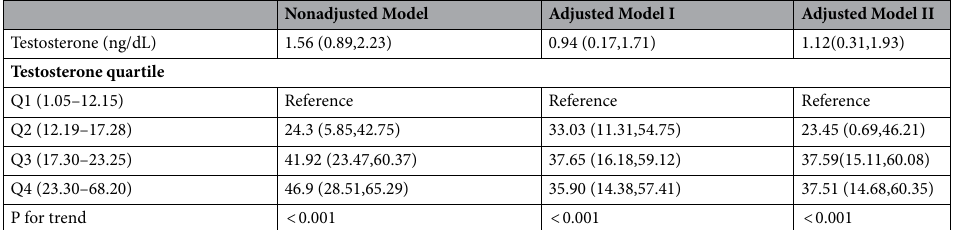
Table 3. Association of testosterone levels with lumbar BMD. Data presented are the β and 95% CI. Model I was adjusted for age, race, and corticosteroid use. Model II was adjusted for the variables in Model I + income level, education level, BMI, blood urea nitrogen level, serum uric acid level, serum calcium level, serum phosphorus level, drinking status, smoking status, ever taking birth control pills, and ever using female hormones. “P for trend” is mainly used to test whether there is a certain linear change trend between the change in the exposure variable of testosterone and the change in the outcome variable of lumbar BMD.